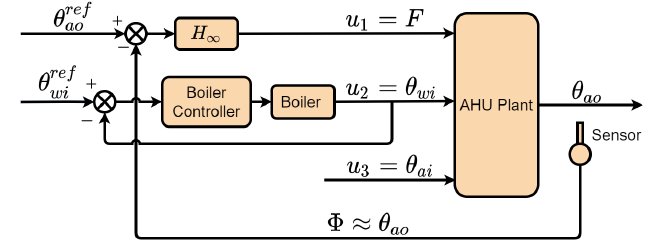
Figure 4. Illustration of conventional control of θ ao .